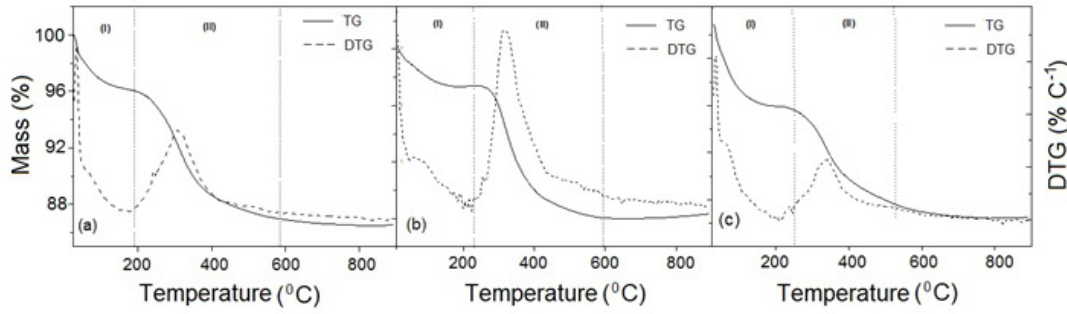
Fig. 3. TG/DTG curves for the non-calcined ZSM-12 zeolites, where: (a) X6, (b) Y6 and (c) W6 samples.